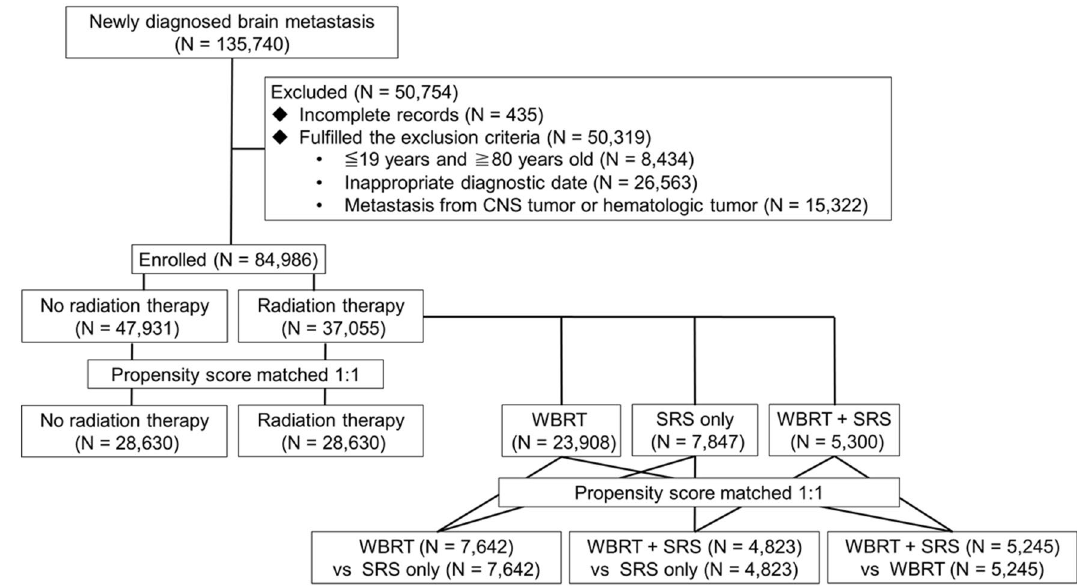
Figure 1. Study flowchart. CNS central nervous system, WBRT whole-brain radiotherapy, SRS stereotactic radiosurgery. Created using R software (version 3.5.2; R Foundation for Statistical Computing, Vienna,